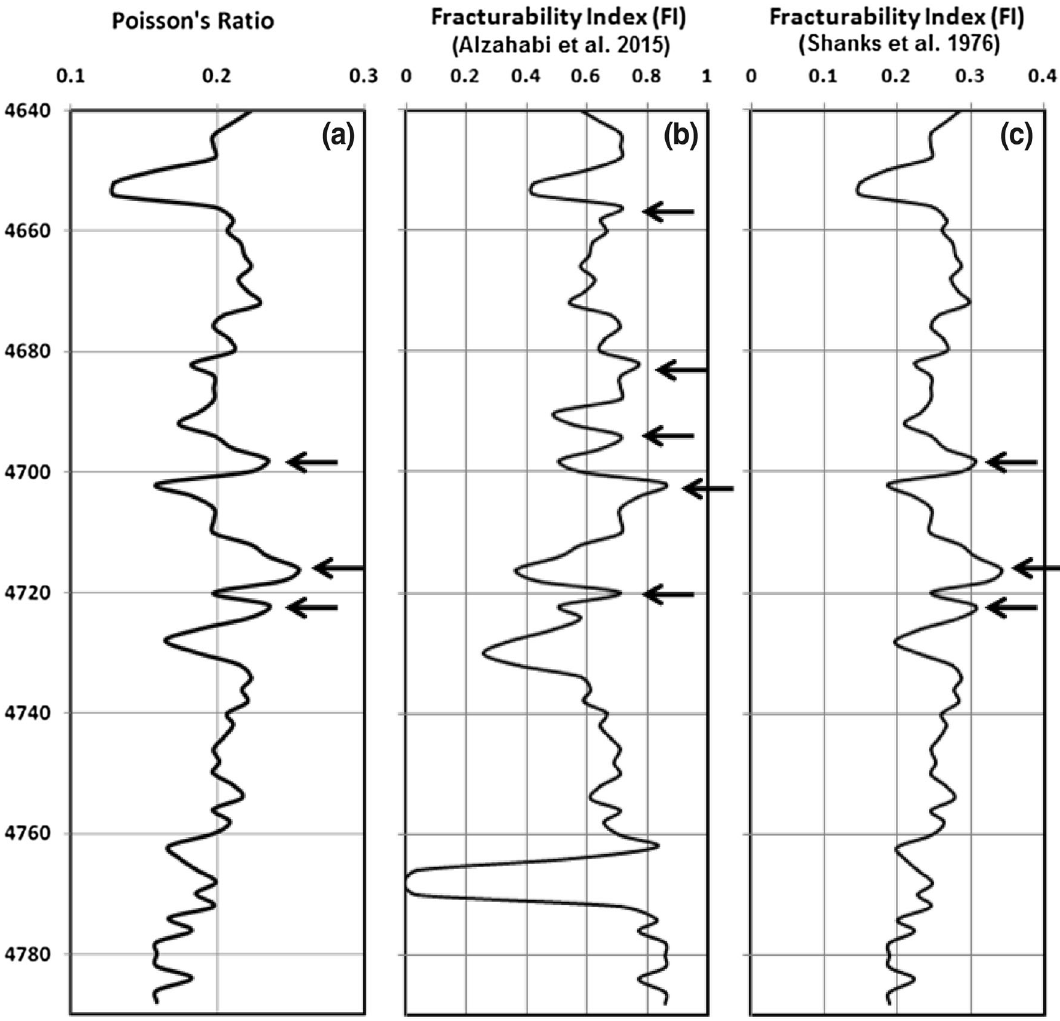
Fig. 10 Fractures indicated by shear wave velocity and fracturability index (FI) obtained from Variable Density log data (VDL) in Geisum-A2